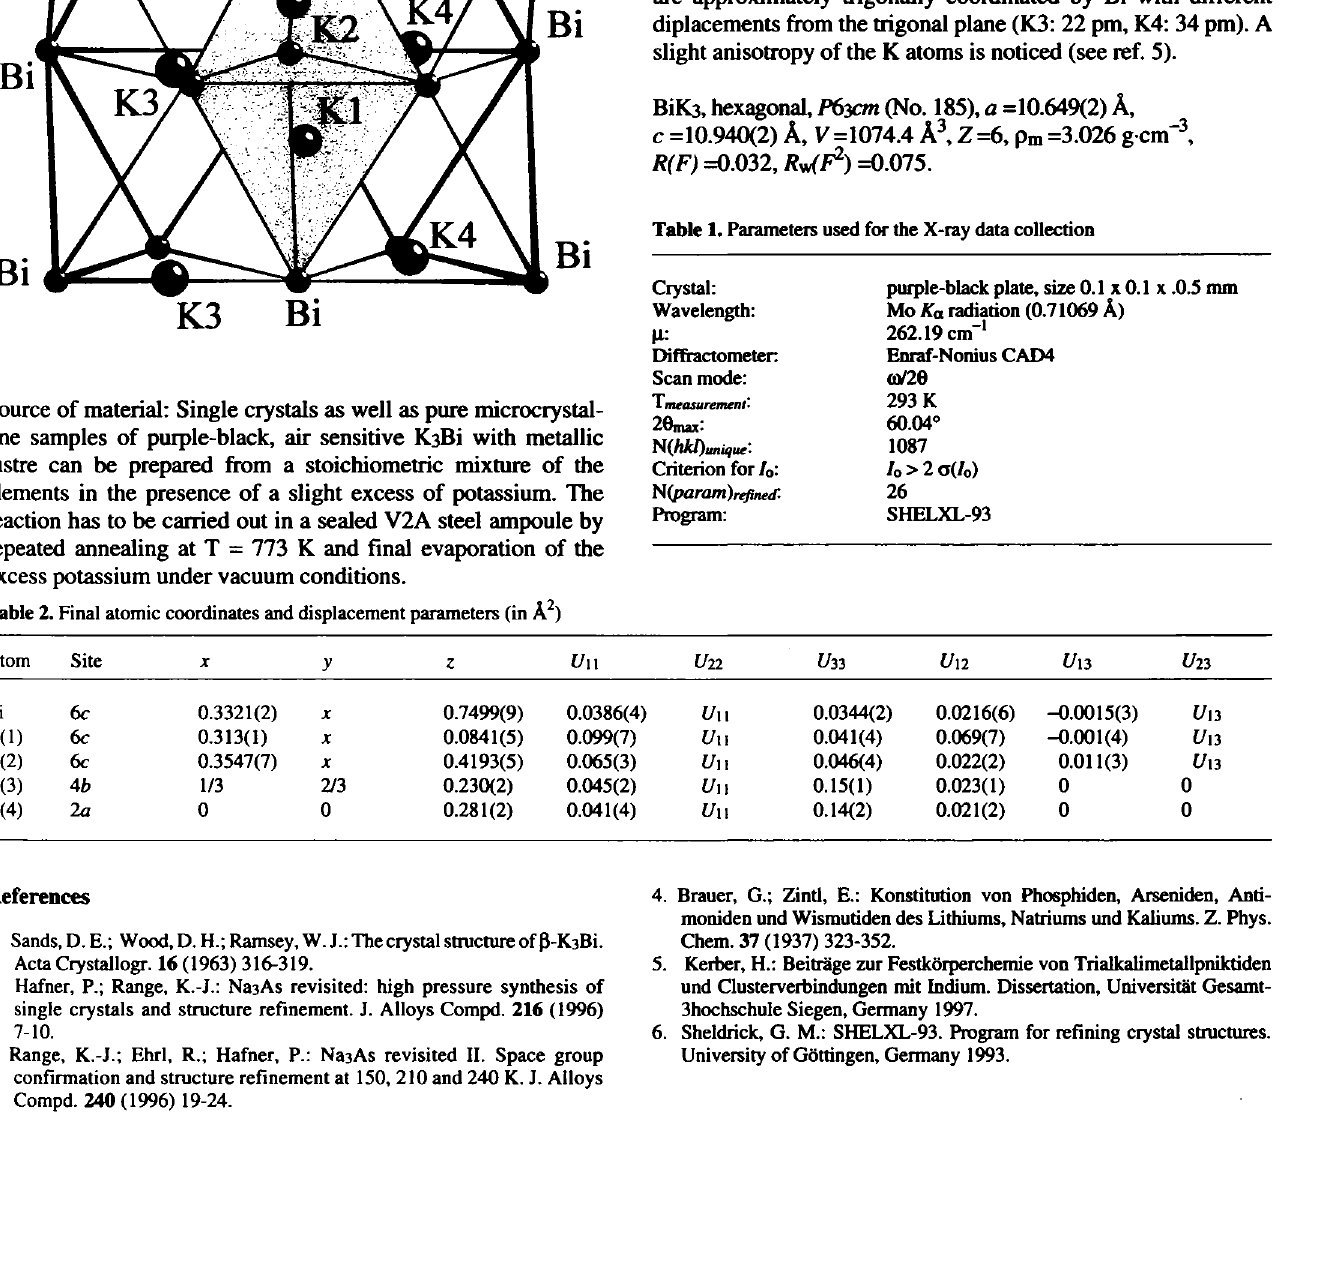
Table 1. Parameters used for the X-ray data collection